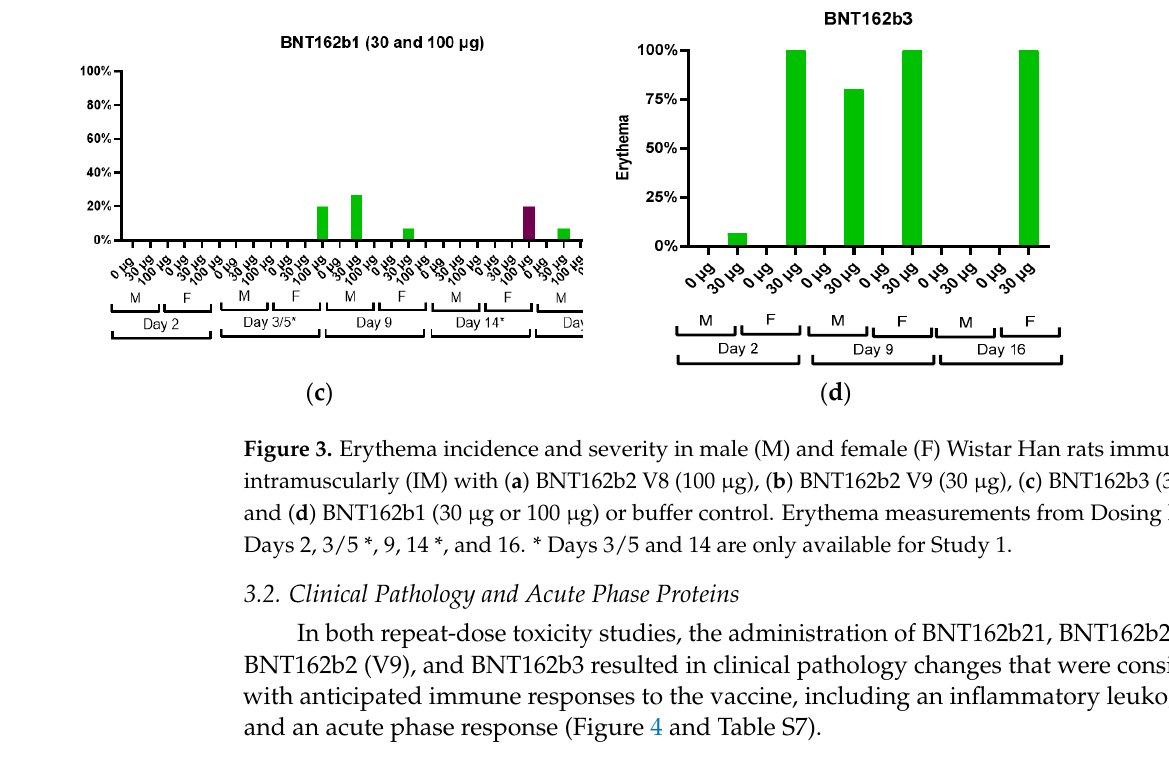
Figure 3. Erythema incidence and severity in male (M) and female (F) Wistar Han rats immunized intramuscularly (IM) with ( a ) BNT162b2 V8 (100 µg), ( b ) BNT162b2 V9 (30 µg), ( c ) BNT162b3 (30 µg), and ( d ) BNT162b1 (30 µg or 100 µg) or buffer control. Erythema measurements from Dosing Phase Days 2, 3/5 *, 9, 14 *, and 16. * Days 3/5 and 14 are only available for Study 1.